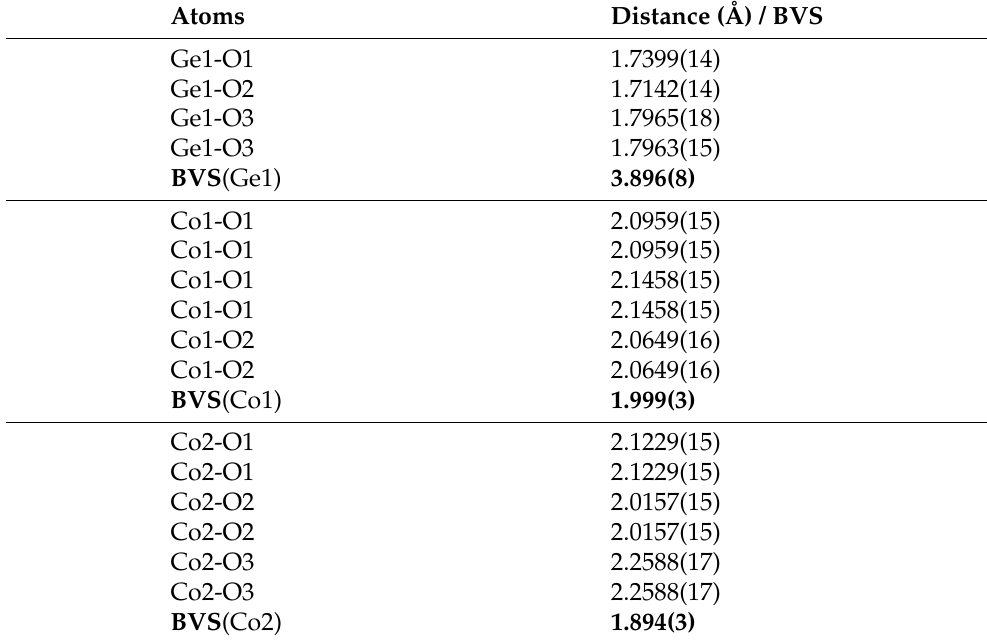
Table 3. Bond lengths and bond valence sums (BVS) in CoGeO 3 . BVS parameters were taken from Ref.